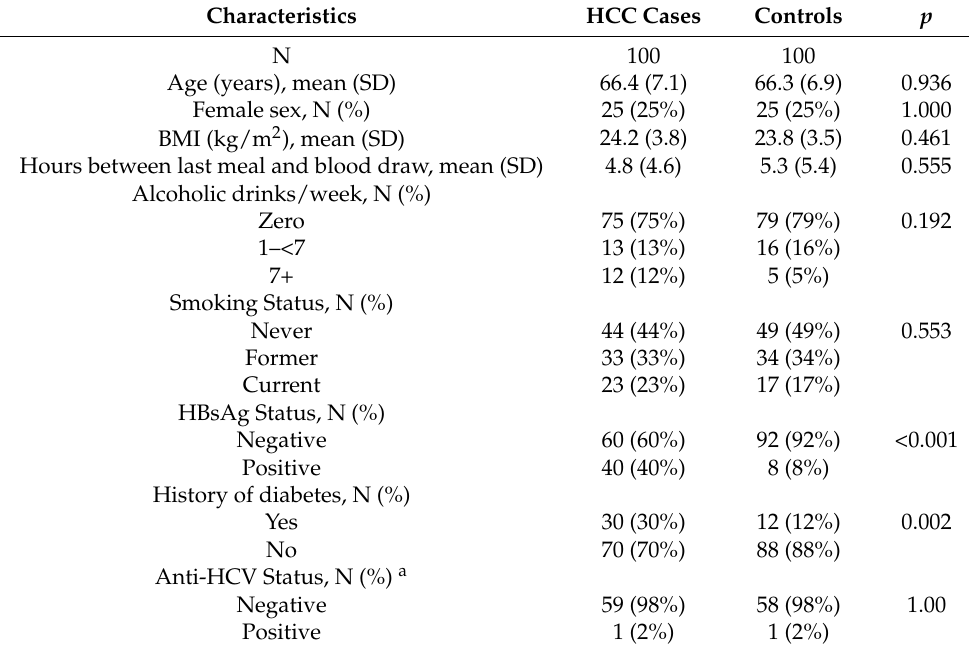
Table 1. Baseline characteristics of hepatocellular carcinoma (HCC) cases and matched controls, The Singapore Chinese Health